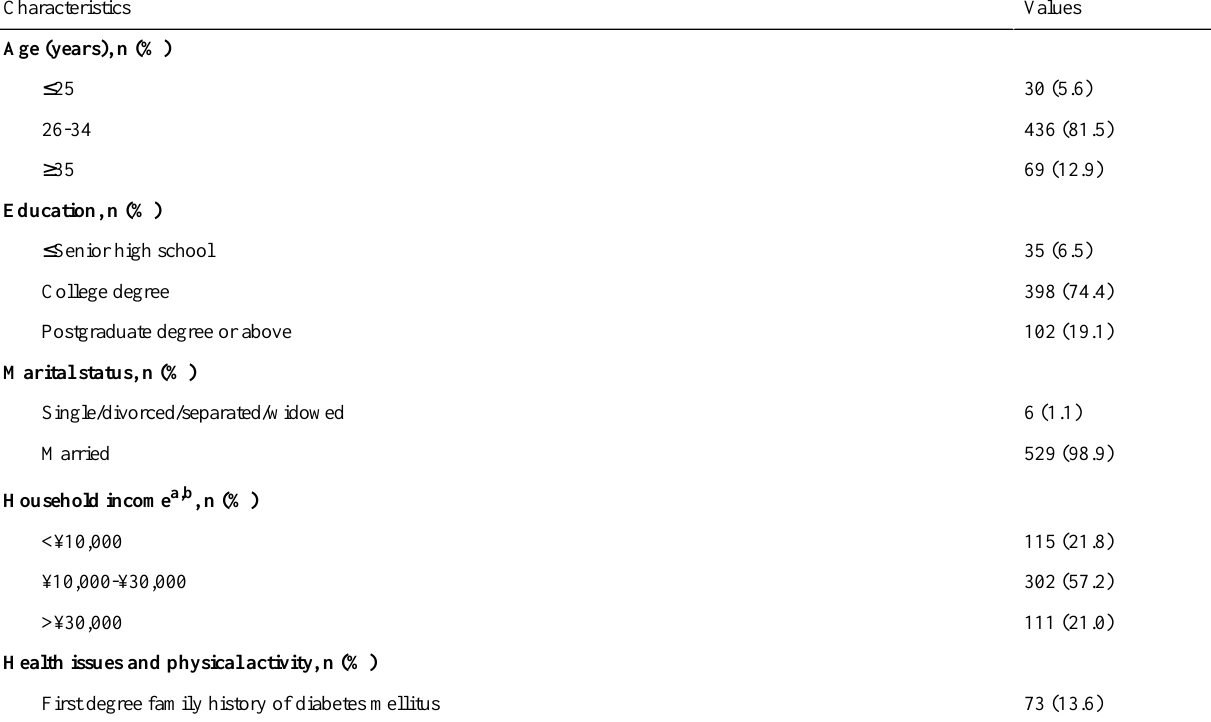
Table 1. Characteristics of study participants in the survey, Shanghai, China, 2018